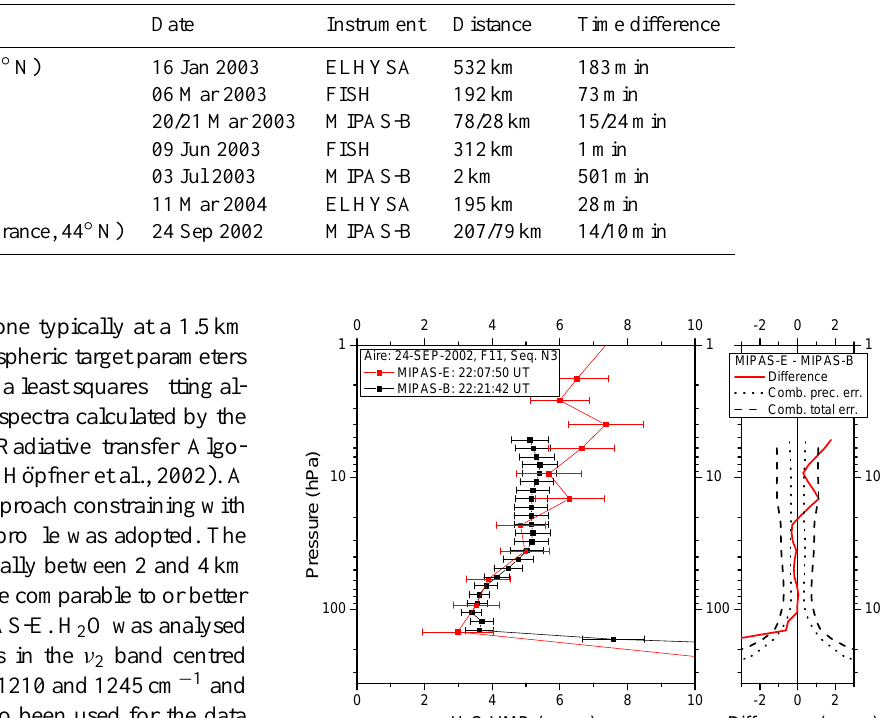
Table 1. Overview of balloon flights used for the validation of MIPAS-E. Distances and times between MIPAS-E and the validation instru- ment refer to an altitude of 20km.